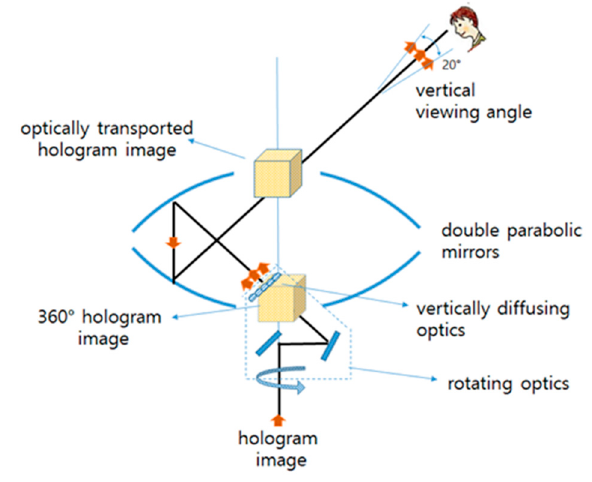
Figure 5. 360-degree volumetric image floating on tabletop display.